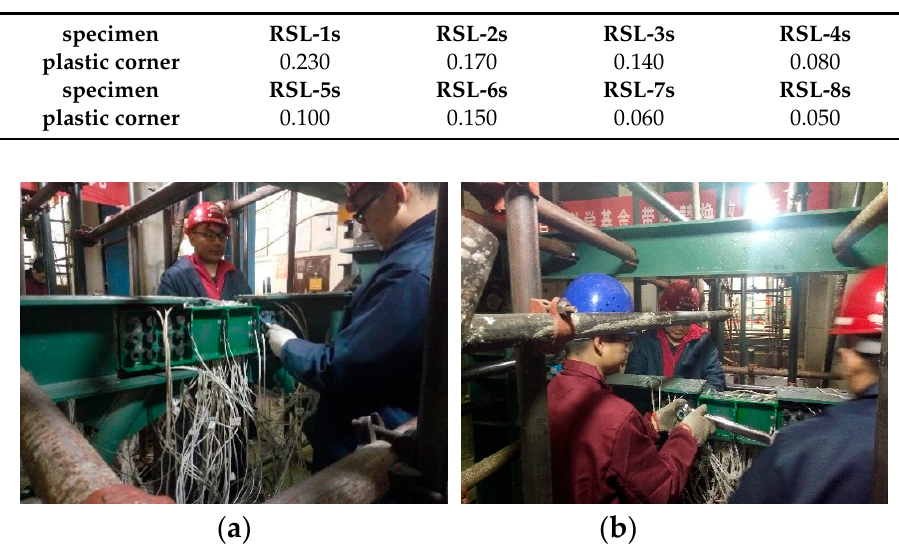
Figure 9. Replacement of energy-dissipating links. ( a ) replacement of connection; ( b ) replacement of connection.